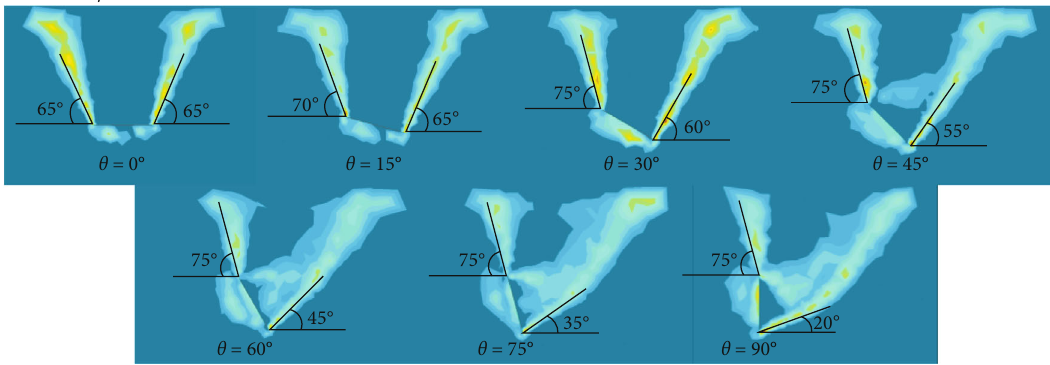
Figure 11: Shear dissipation of circular anchor plate for loose sand at di ff erent θ .